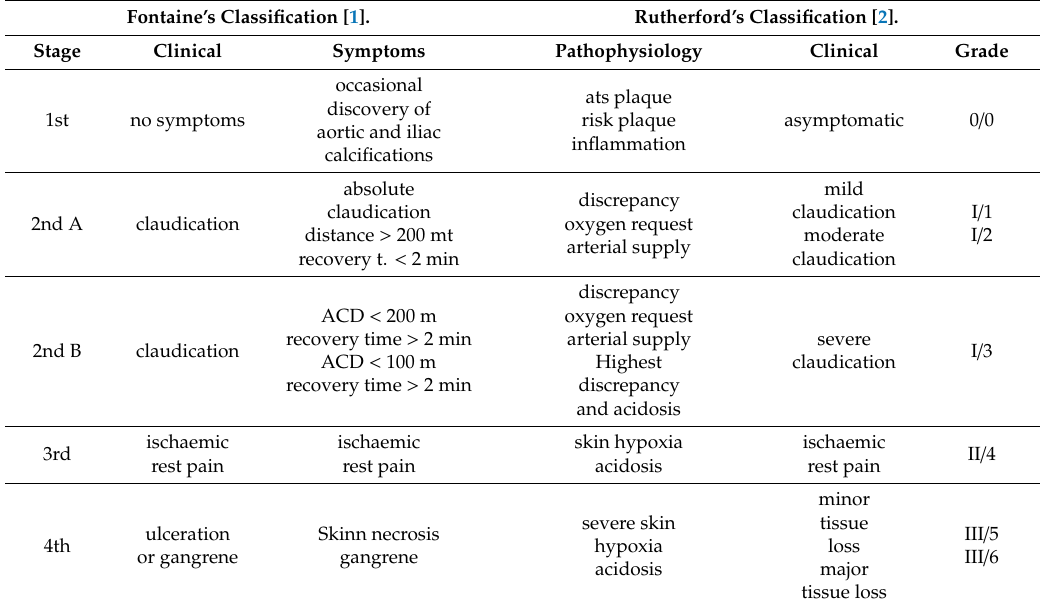
Table 1. Progression and staging of peripheral arterial disease (PAD) by based on two most applied